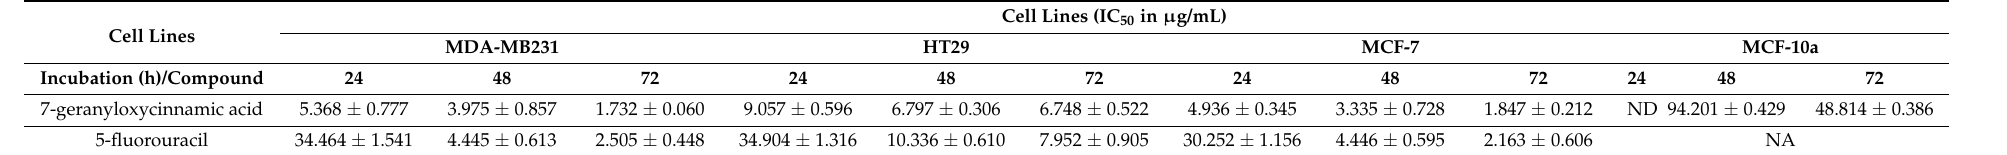
Table 4. IC 50 values of 7-geranyloxycinnamic acid and 5-fluorouracil on human breast cancer MDA-MB231, human colon cancer HT29, human breast cancer MCF-7, and human normal breast MCF-10a cells after 24, 48, and 72 h of